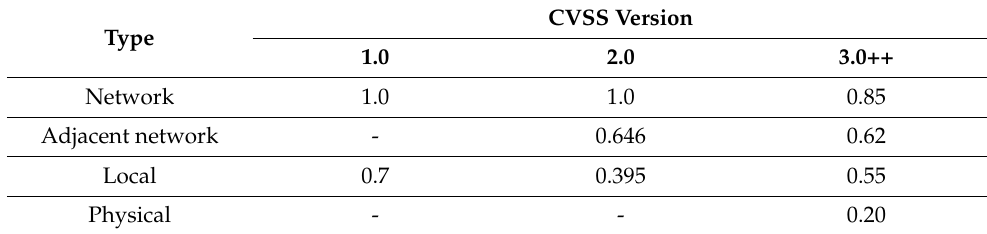
Table 1. Access location weight according to CVSS version.